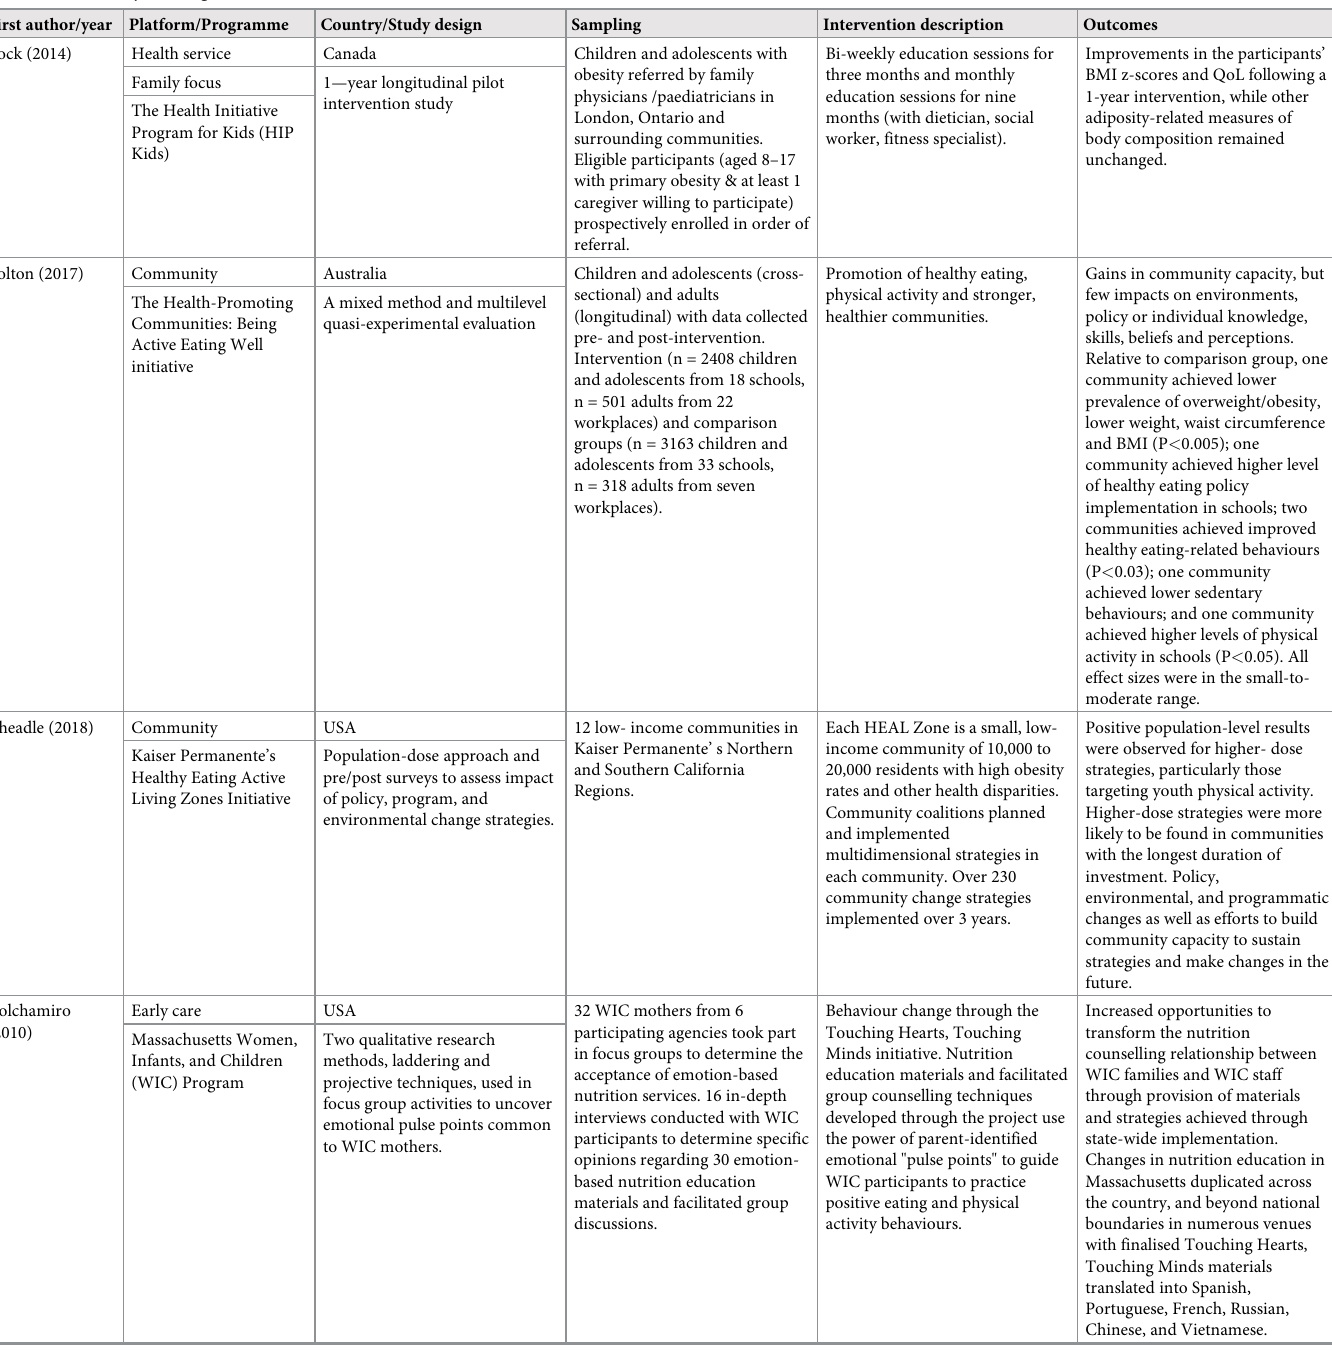
Table 1. Summary of integrated